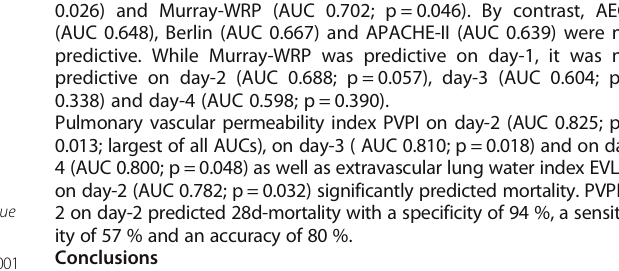
Table 75 (abstract A229). Distribution of outcome in patients with mild ARDS at onset